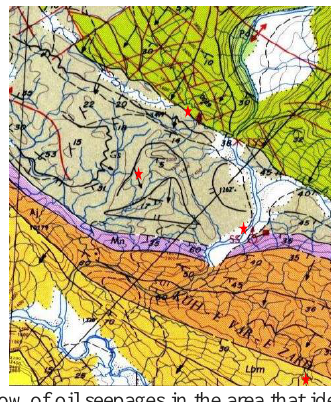
Figure 4. Show of oil seepages in the area that identified in this study